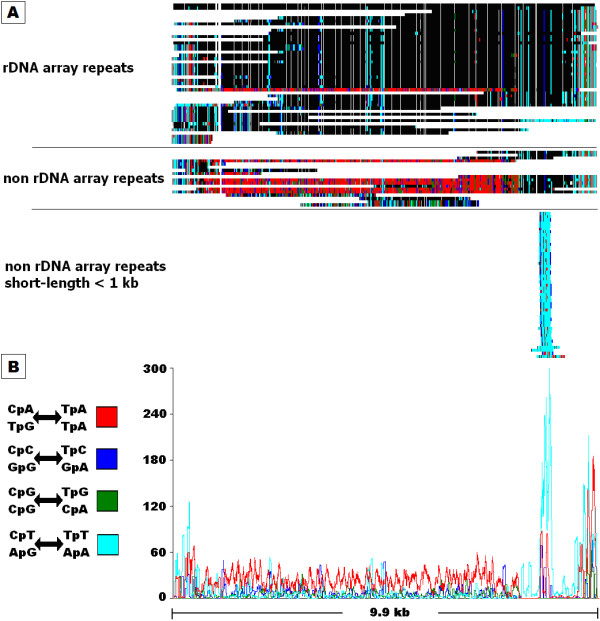
RIPCAL analysis of the rDNA tandem repeat of Stagonospora nodorum. A) multiple alignment of the rDNA repeat family compared to highest G:C content model. Annotation is as for figure 3. Classical CpA↔TpA type RIP mutations are generally limited to full length rDNA-like repeats not located within the rDNA tandem array. One copy within the rDNA array exhibits RIP-like alterations. B) Overall RIP mutation frequency graph over a 50 bp scanning window, corresponding to the alignment above, demonstrating even dominance of CpA↔TpA changes in the non-array full-length repeats except near each end of the alignment.